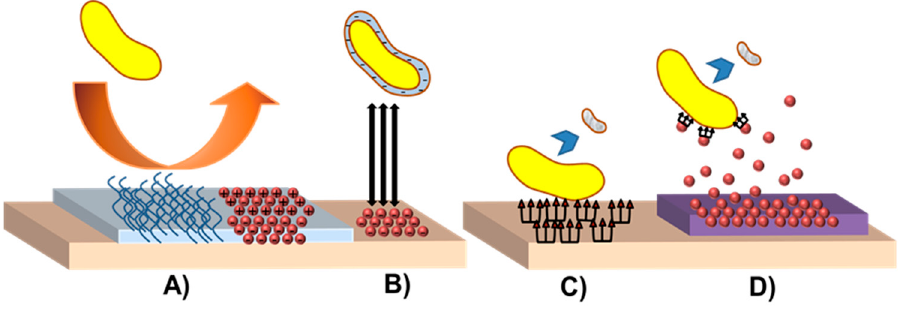
Figure 2. General strategies to the development of antibacterial surfaces based on: ( A ) steric, ( B ) electrostatic, ( C ) Contact killing and ( D ) biocide release effects.